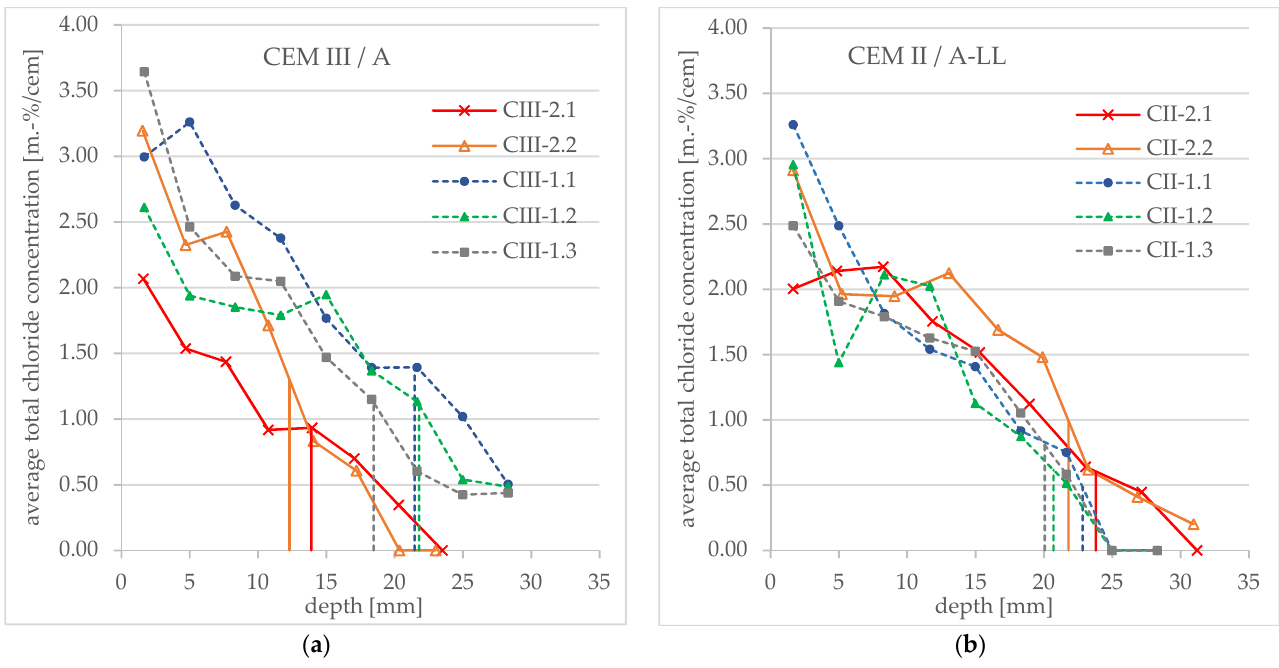
Figure 6. Total chloride concentration profiles obtained after an RCM test and average penetration depth (vertical lines) measured after spraying AgNO 3 ( a ) for CEM III/A concrete specimens and ( b ) for CEM II/A-LL concrete specimens.